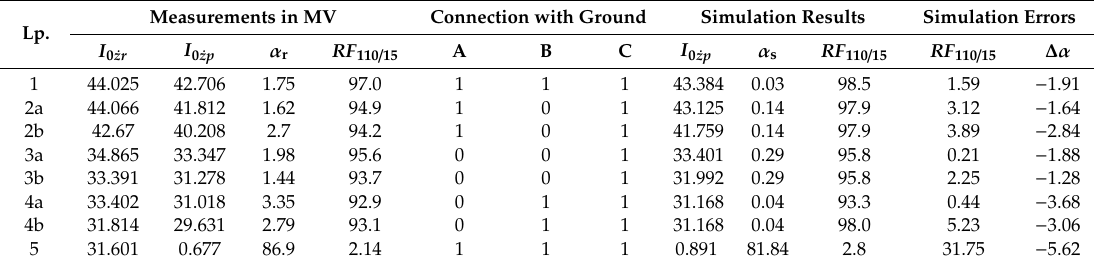
Table 2. Results of network tests.